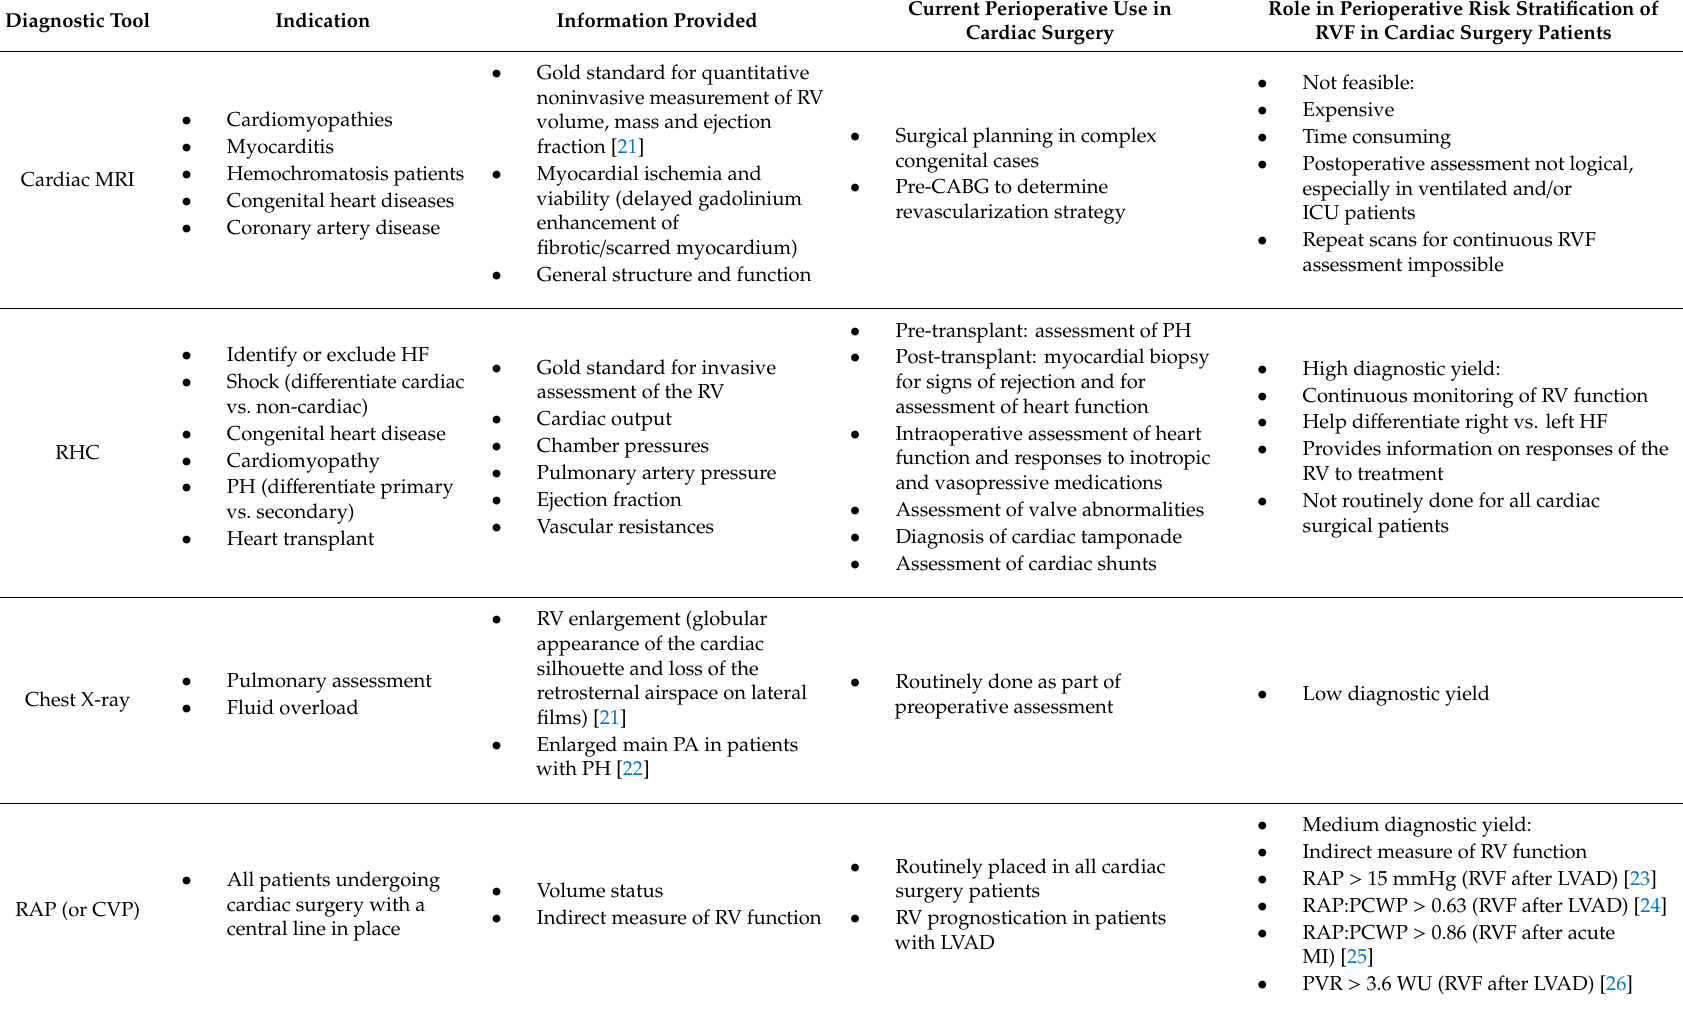
Table 2. Current perioperative right ventricular (RV) assessment